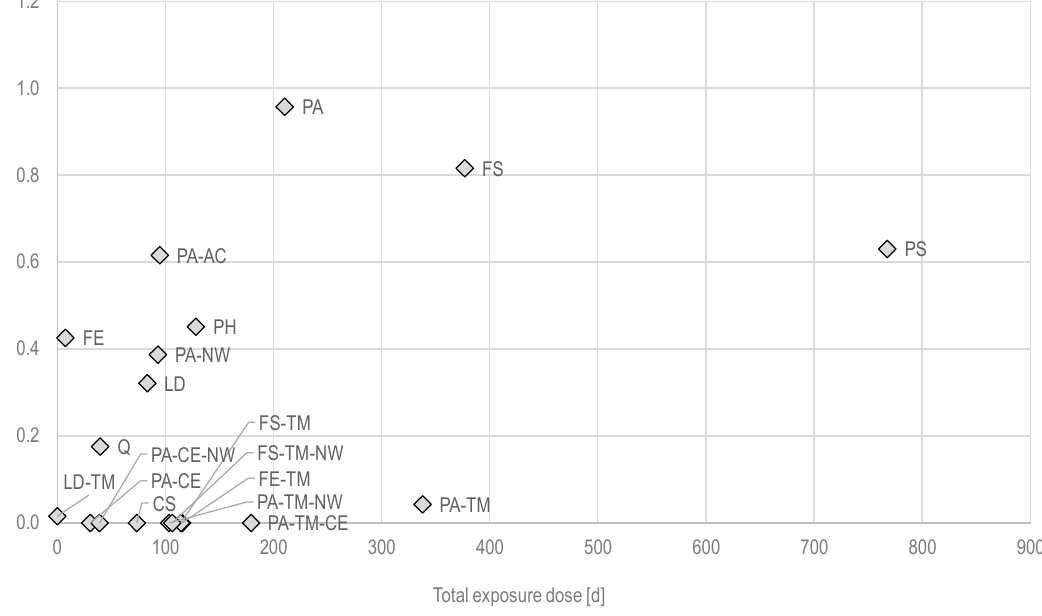
Figure 6. Mean decay rate of decking at the model house in Ljubljana versus the total exposure dose.